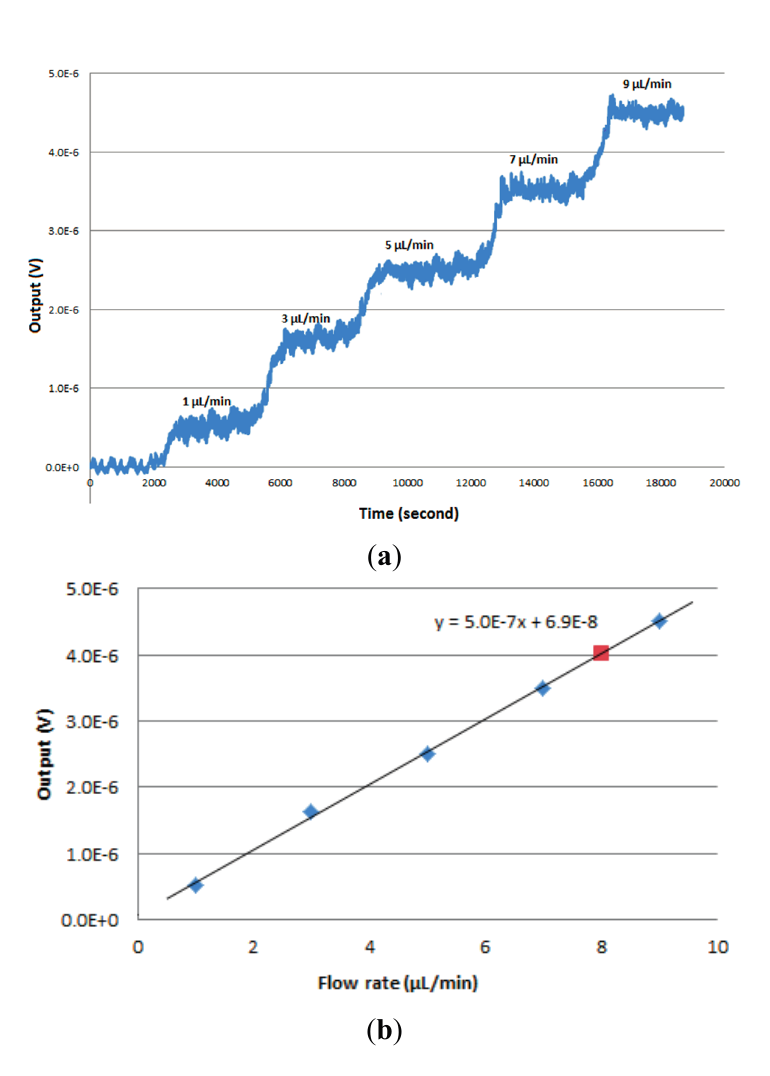
Figure 6. ( a ) Output signal at different flow rates in TRIS/HCl reaction; ( b ) Output signal vs. flow